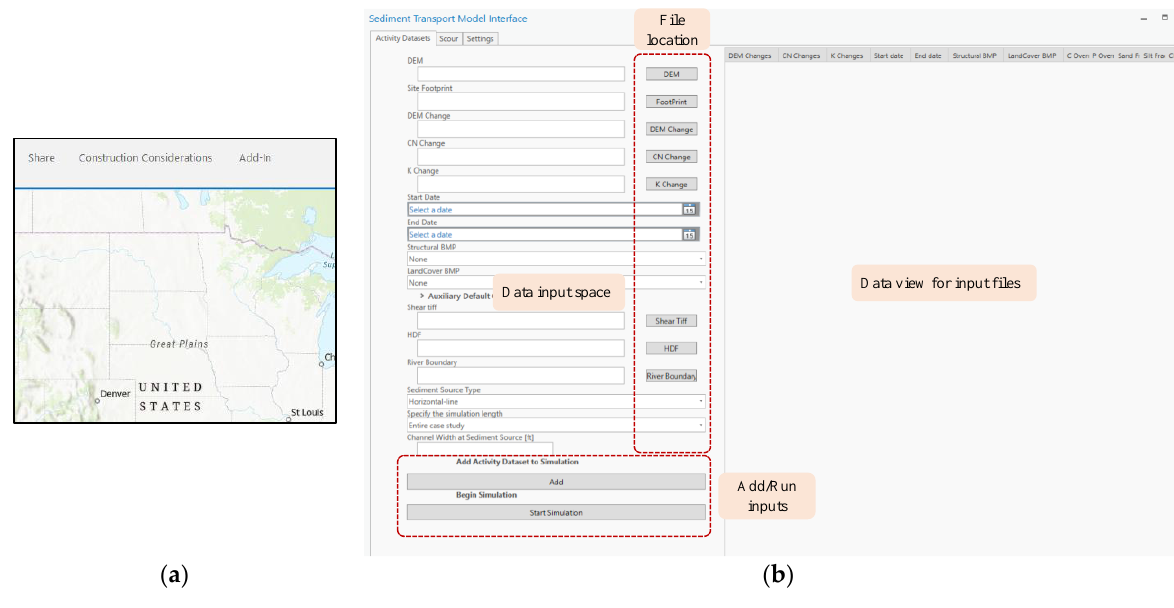
Figure 3. ( a ) GIS toolkit interface, and ( b ) Data entry space.